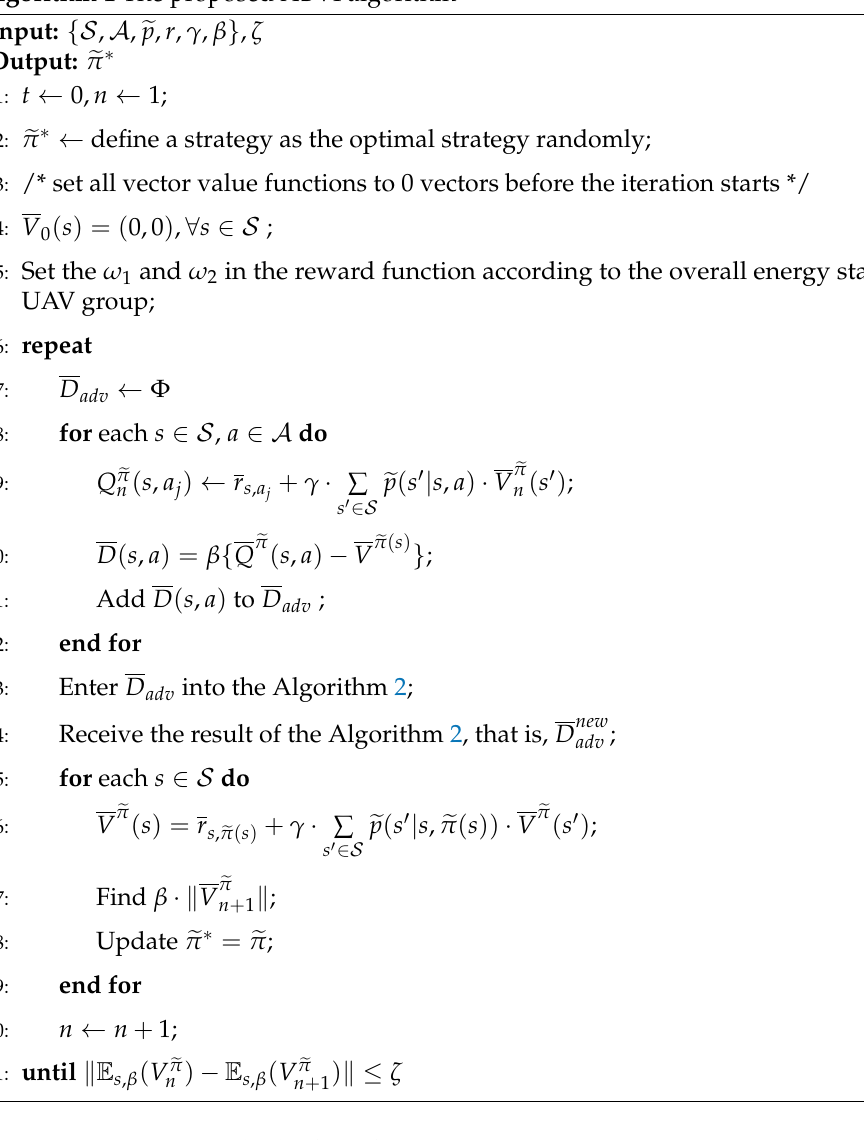
Algorithm 1 The proposed ABVI